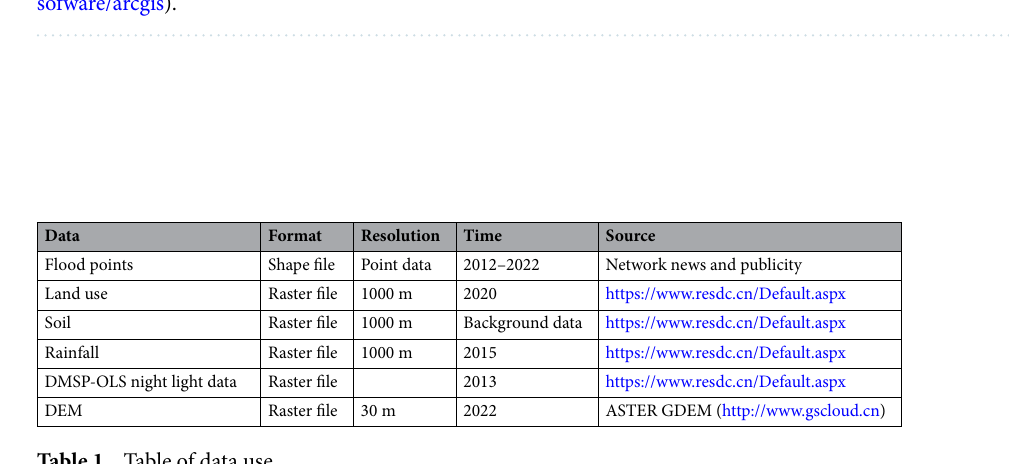
Figure 2. Map of flood and non-flood locations (we plotted the map using arcgis10.7. http:// www. esri. com/ sofwa re/ arcgis).